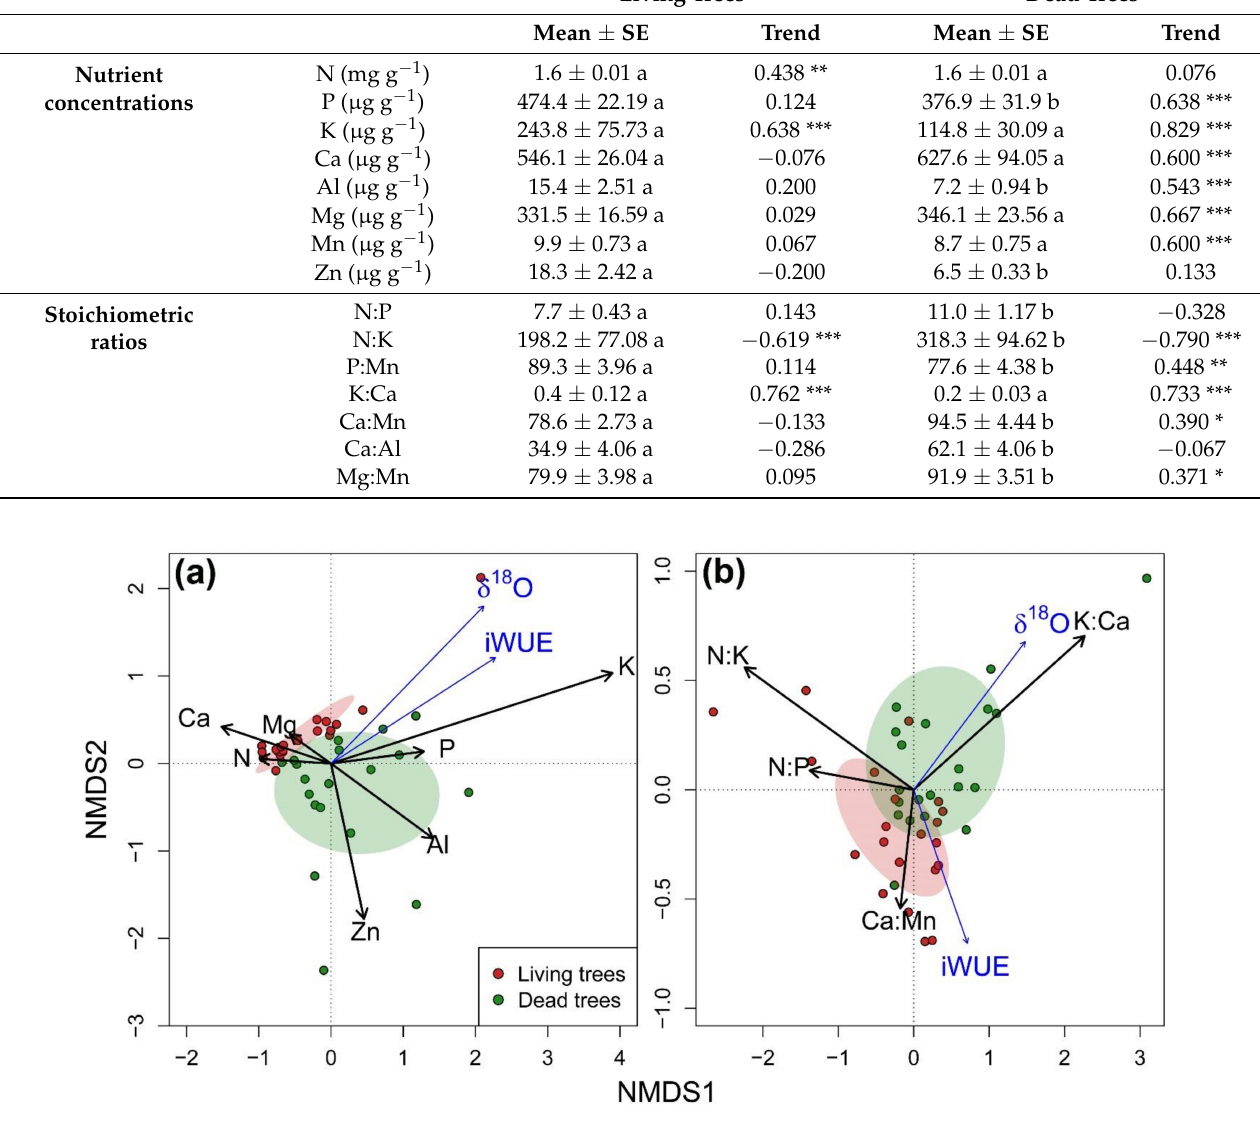
Figure 6. Non-metric multidimensional scaling (NMDS) biplots of nutrient concentrations ( a ) and stoichiometric molar ratios ( b ) of living (L; green symbols and areas) and dead (D; red symbols and areas) trees. Points represent the values of each group of five consecutive rings for the period 1915–2018. Shaded areas represent the centroid of the values for each tree-vigor class. Black arrows indicate loadings of nutrient concentrations ( a ) and molar ratios ( b ) in NMDS axes; those very close to the point (0,0) are not shown for the sake of clarity. The correlation between intrinsic water-use efficiency (iWUE) and oxygen isotope composition ( δ 18 O) and NMDS axes was projected in the ordination diagram and represented with blue arrows. iWUE and δ 18 O were detrended using ensemble empirical mode decomposition (EEMD) technique prior